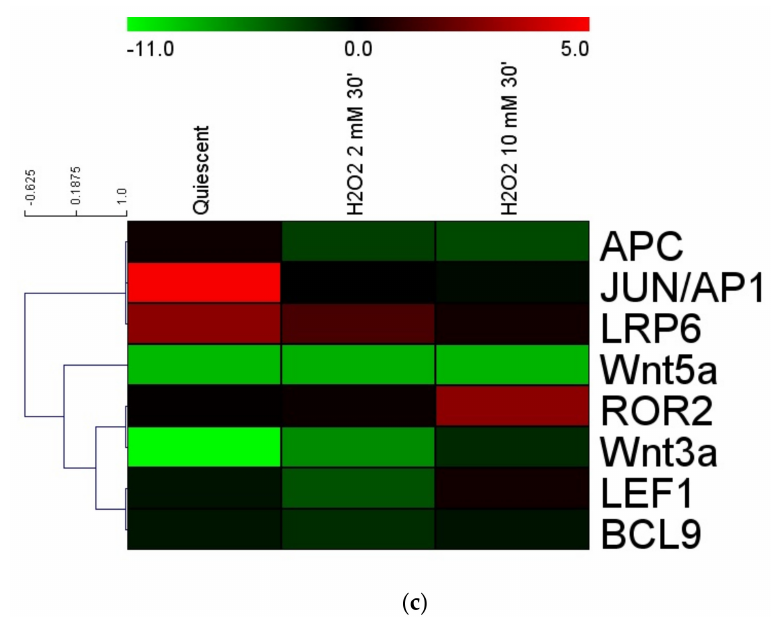
Figure 3. Gene expression cluster analysis by MeV4.9.0 in CRC quiescent cells treated by H 2 O 2 [2 mM]: ( a ) HCT116 cells; ( b ) SW480 cells; ( c ) SW620 cells. The average linkage hierarchical clustering with Pearson correlation was used. The color scale at the top represents the log2 of every single gene expression value compared to housekeeping value ranging from. − 11 (green) to 4 (red). The trees presented here are the neighbor-joining trees based on gene expression variation in response to different treatments.